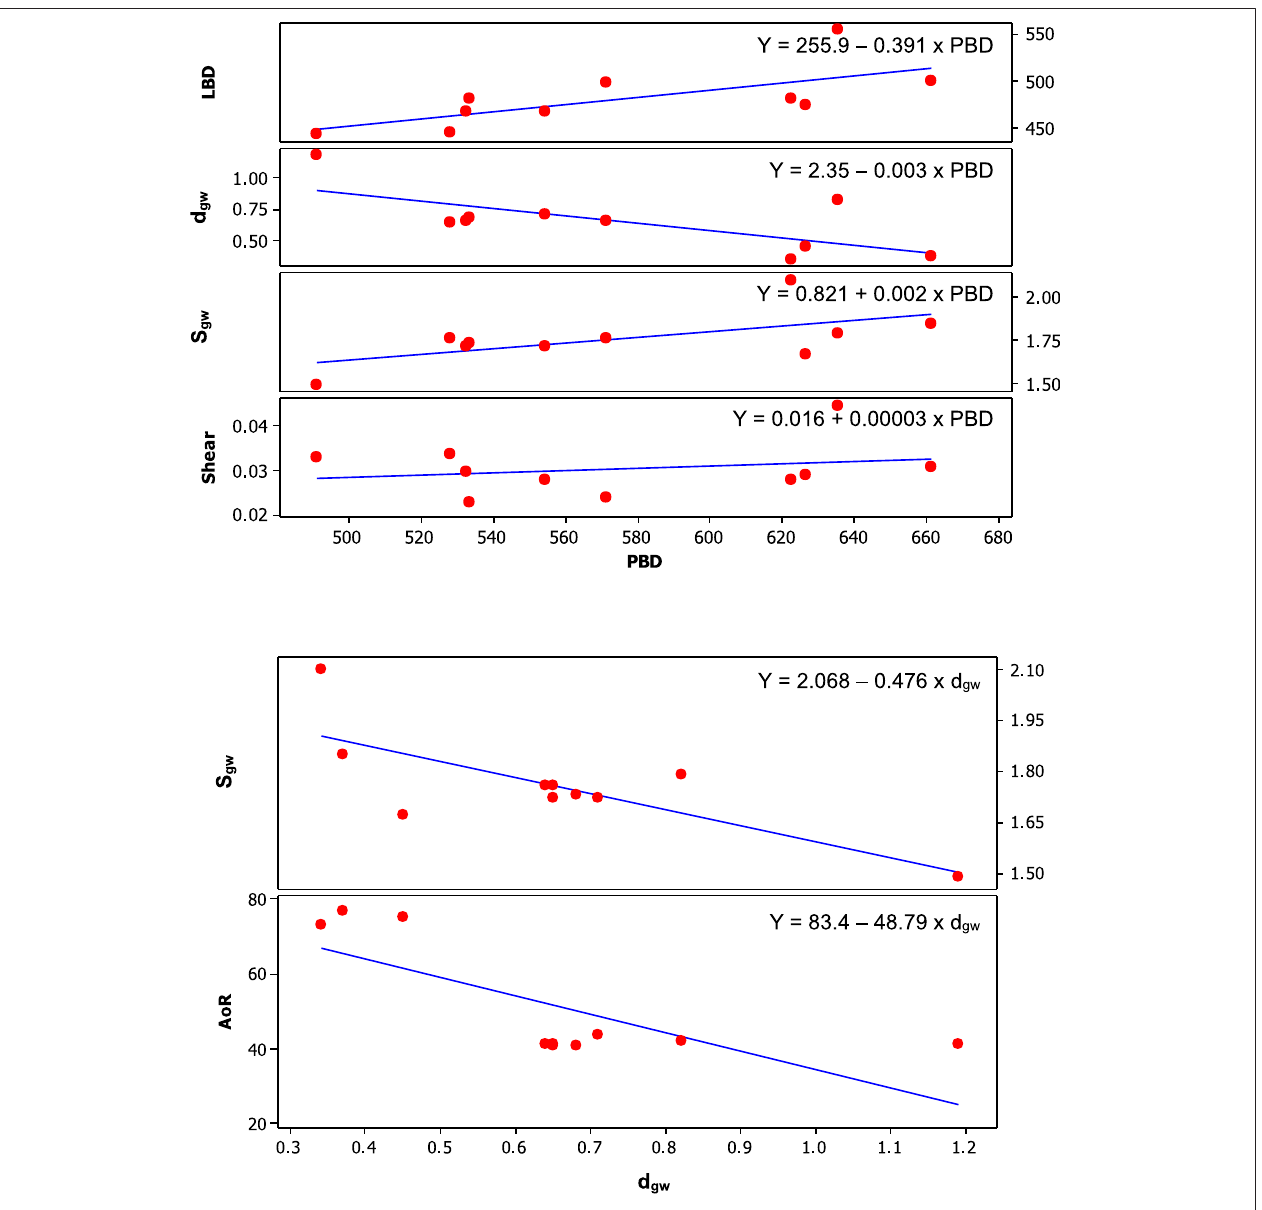
FIGURE 3 | Predictions for strongest linear relationships found in Figure 2 ( p < 0.05). Packed bulk density appears to be signi fi cantly related toloose bulk density, particle size (d gw and S gw ), and shear strength. d gw appears to be signi fi cantly related to S gw and angle of repose. As average particle size (d gw ) increased, particle standard deviation (S gw ) and angle of repose